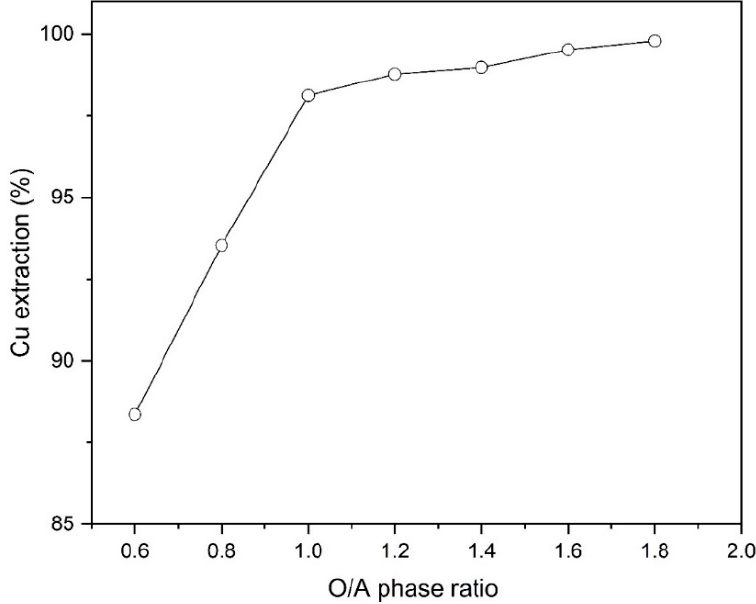
Figure 6. The effect of different phase ratios (O/A) on Cu extraction percentage (Mextral 5640H = 10% ( v / v ), pH = 1.6, T= 25 ° C, t = 10 min and rpm = 400).